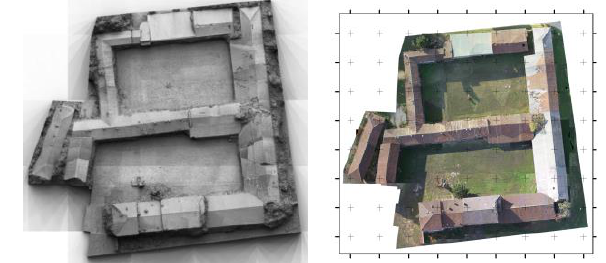
Figure 11 Depth maps obtained with MicMac (shaded mode) (left) and achieved orthophoto (right)